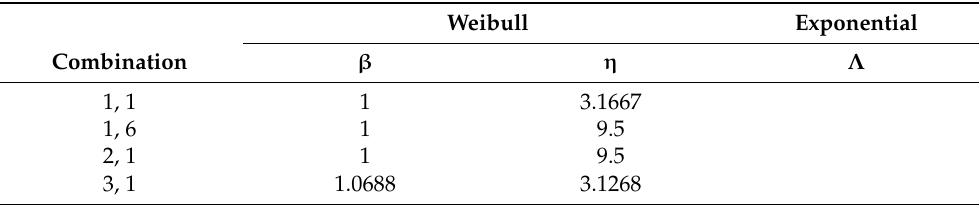
Table 7. Component–subsystem relationships presented in the failure analysis and their parameters from 25 to 30 January 2021.